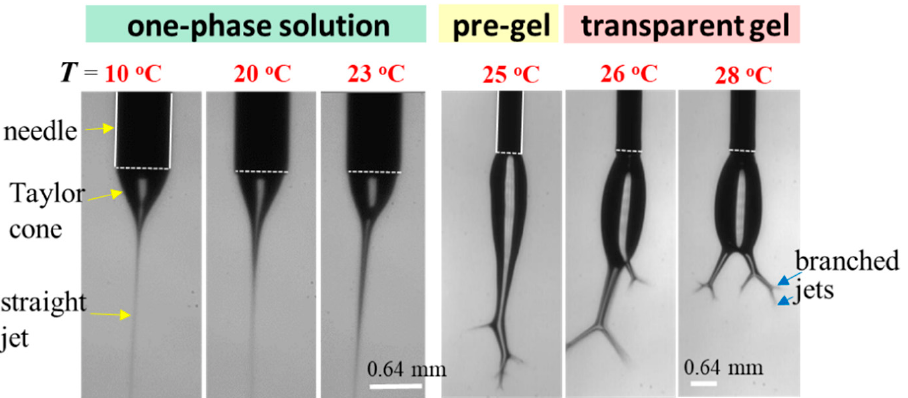
Figure 15. Effect of solution temperature on the cone/jet morphology during the electrospinning of the 10 wt% a-PNIPAM/water mixture. The scale bar is 0.64 mm. The bright line appearing on the cone was caused by the light source used for illumination.